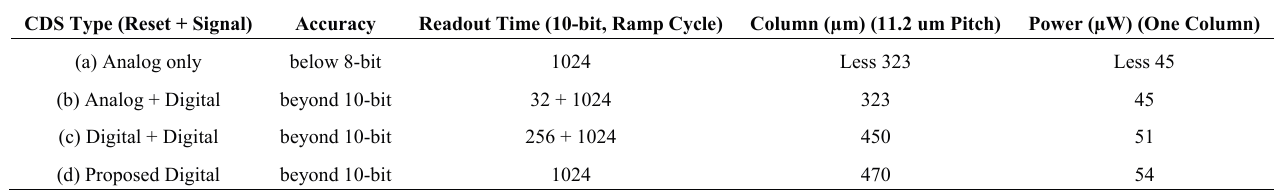
Table 1. Comparison of each CDS (Samsung 0.13 um CIS technology).